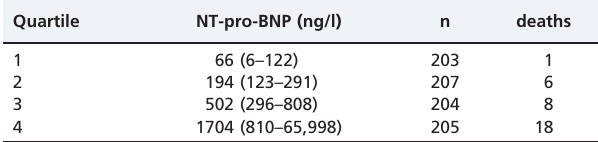
Table 3 - Overall death rate (n= 33) of 819 coronary artery bypass patients grouped according to quartiles of serum N-terminal pro-brain type natriuretic peptide (NT-proBNP) levels.